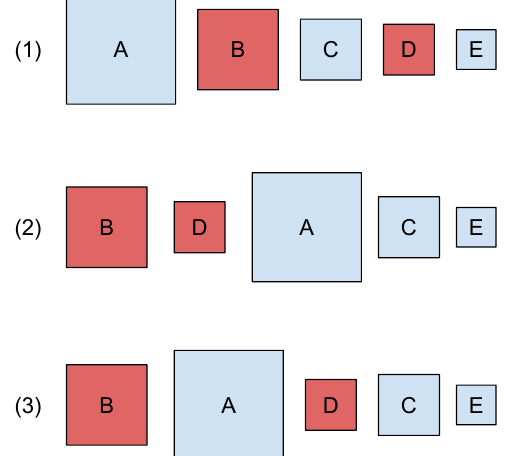
Figure 7: Different weight functions. Highest weight feature is on the left, lowest weight feature is on the right.(1) Surface weight. (2) Combined surface and attribute weight. w 1 = w 2 = 1 . (3)Combined surface and attribute weight. w 1 = 1 , w 2 = 0 . 5 .